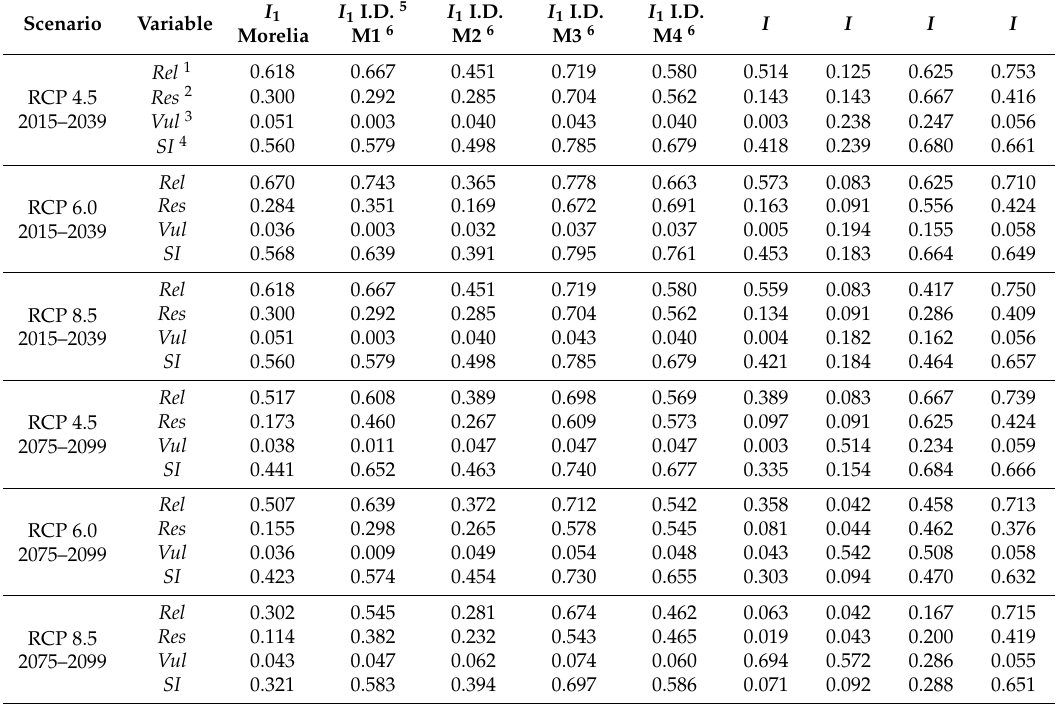
Table 8. Reliability, resilience, vulnerability, and SI index I 1 , I 2 , I 3 , I 4 , and I 5 for current climate change